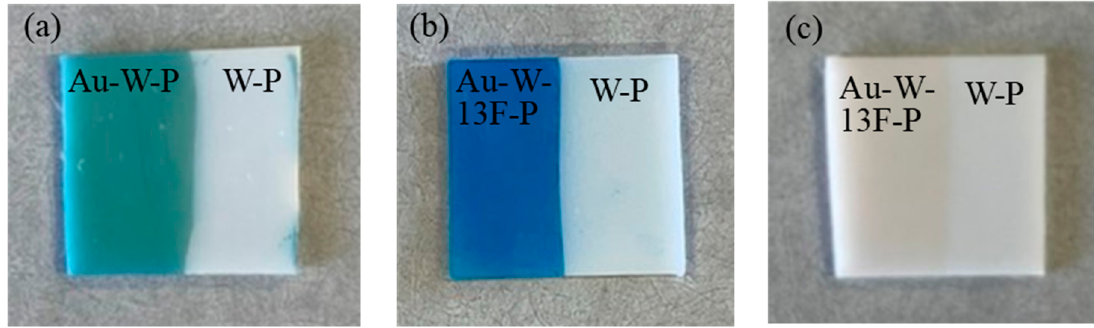
Figure 10. Photographs of dye staining of various PTFE samples with ( a , b ) methylene blue and ( c ) AR52 solutions.